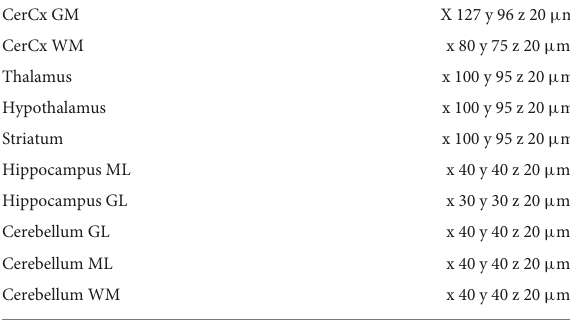
TABLE 2 Size of 3D counting probes per